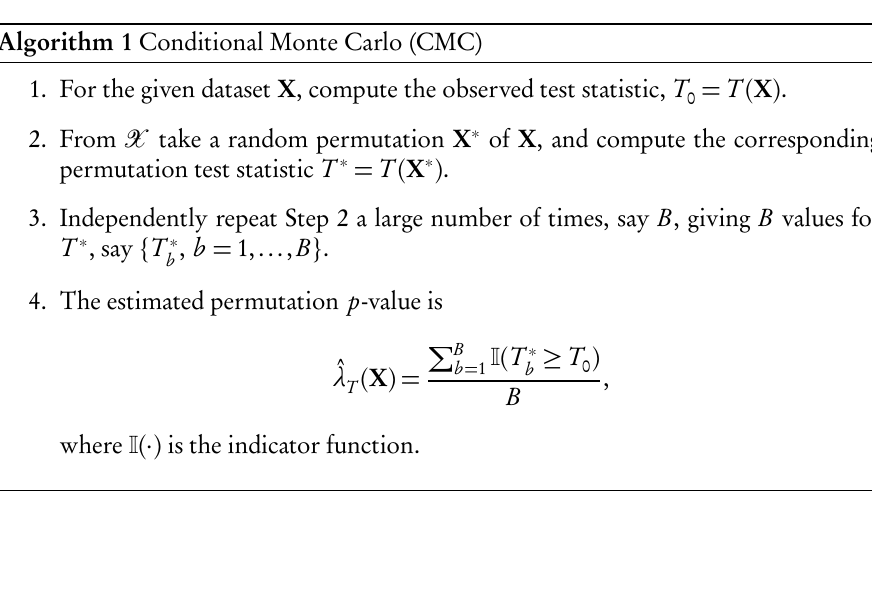
Algorithm 2 Power Function of Permutation